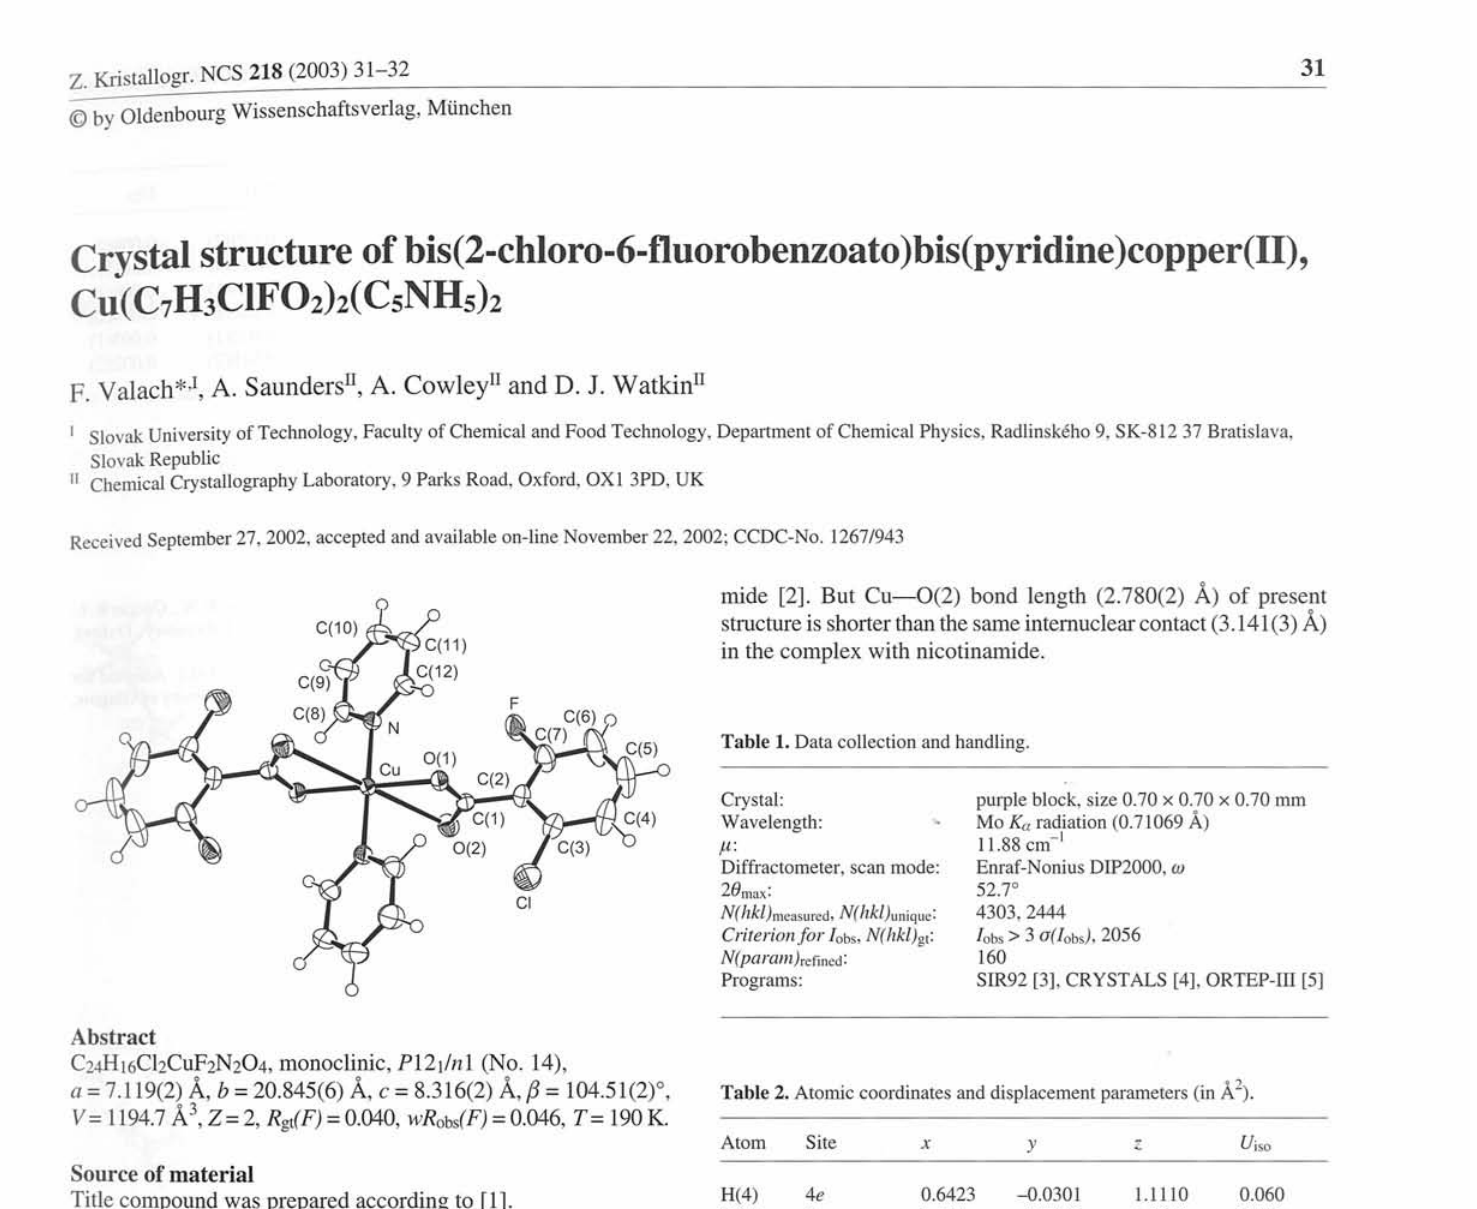
The bond distances and angles do not show any large deviations.